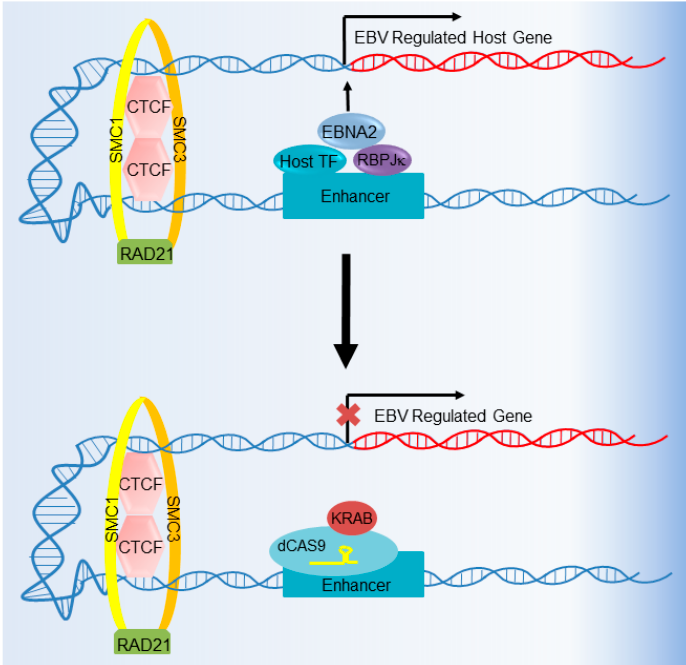
Figure 7. CRISPRi-mediated host enhancer deactivation. CRISPRi can be used to decommission transcription regulatory elements, including host enhancers bound by viral and/or host transcription factors. In this example, CRISPRi is used to deactivate a host enhancer occupied by Recombination Signal Binding Protein for Immunoglobulin κ J Region (RPB-J κ) , Epstein–Barr nuclear antigen 2 (EBNA2), and host transcription factors (TFs). Also shown are the DNA-looping factors CCCTC-Binding Factor (CTCF), Structural Maintenance of Chromosomes 1 (SMC1), SMC3, and RAD21, which facilitate long-range enhancer–promoter interactions.